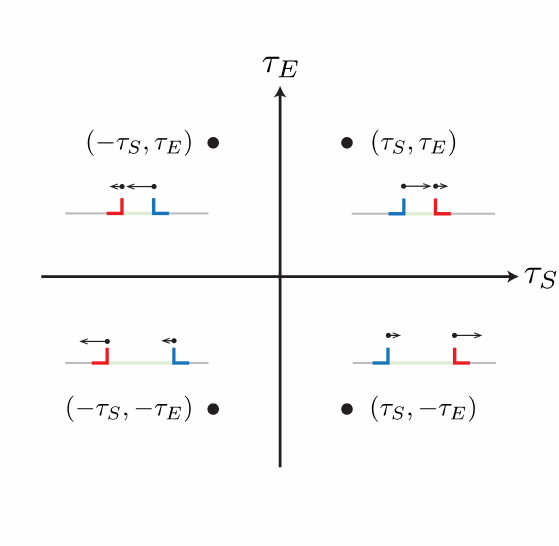
Figure 3. Schematic diagram of the forces felt by the partial dislocations under four different stress states: ( τ S , τ E ) , ( − τ S , τ E ) , ( τ S , − τ E ) and ( − τ S , − τ E ) . The leading and trailing partials in each case are coloured in red and blue, respectively, and the arrows represent the direction and magnitude of the individual